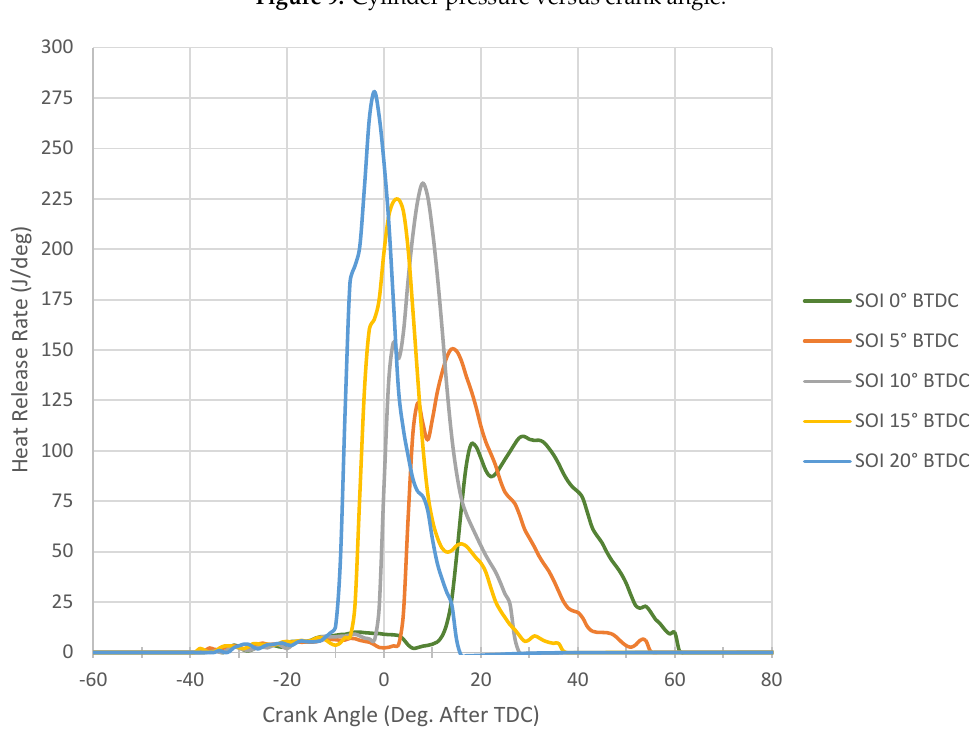
Figure 9. Cylinder pressure versus crank angle.